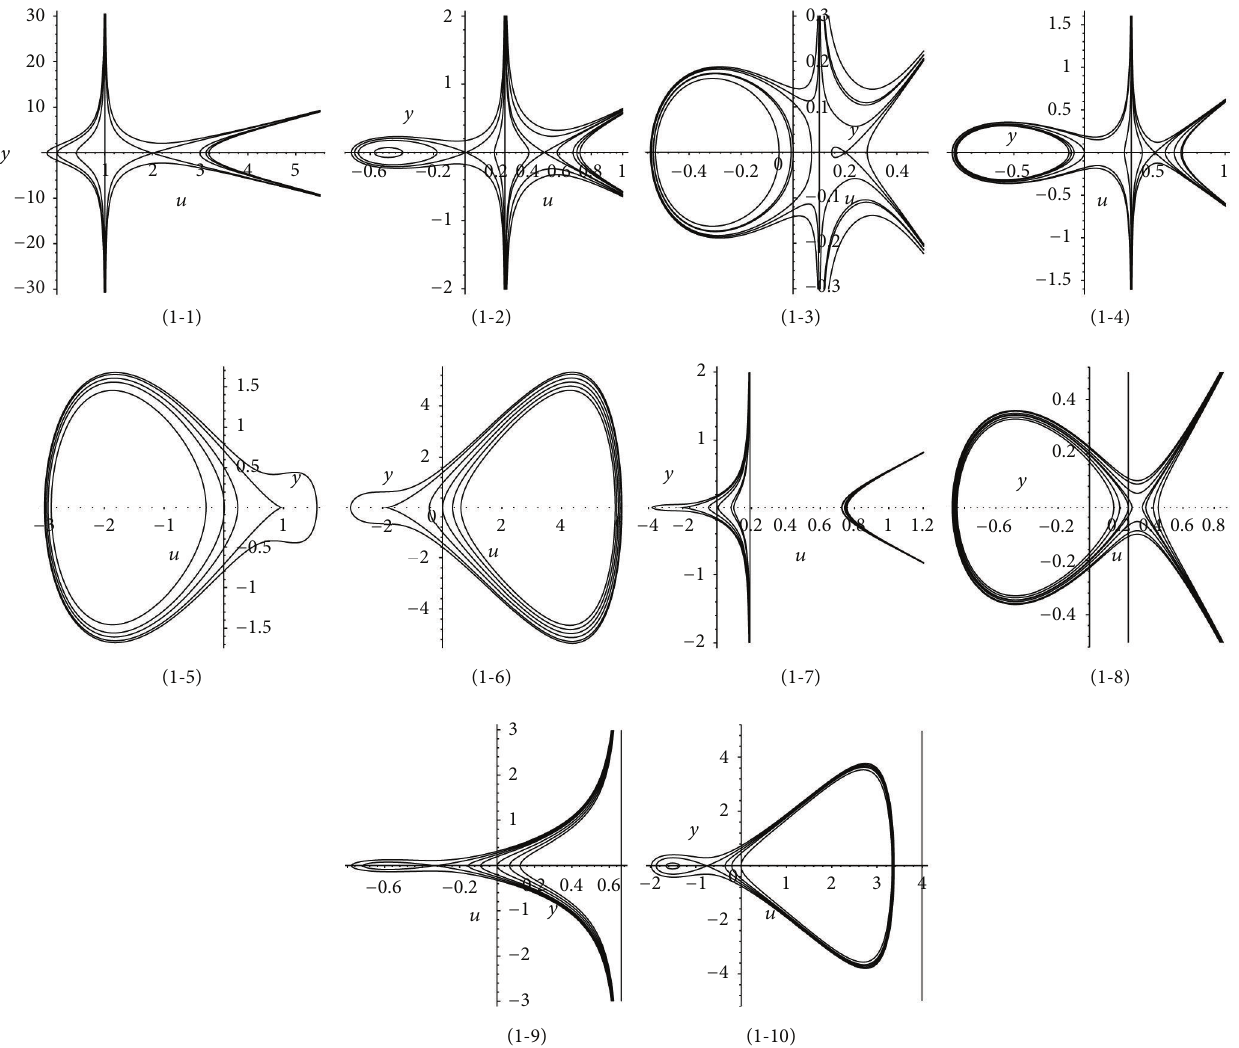
Figure 1: Phase portraits of (3) under the inhomogeneous boundary